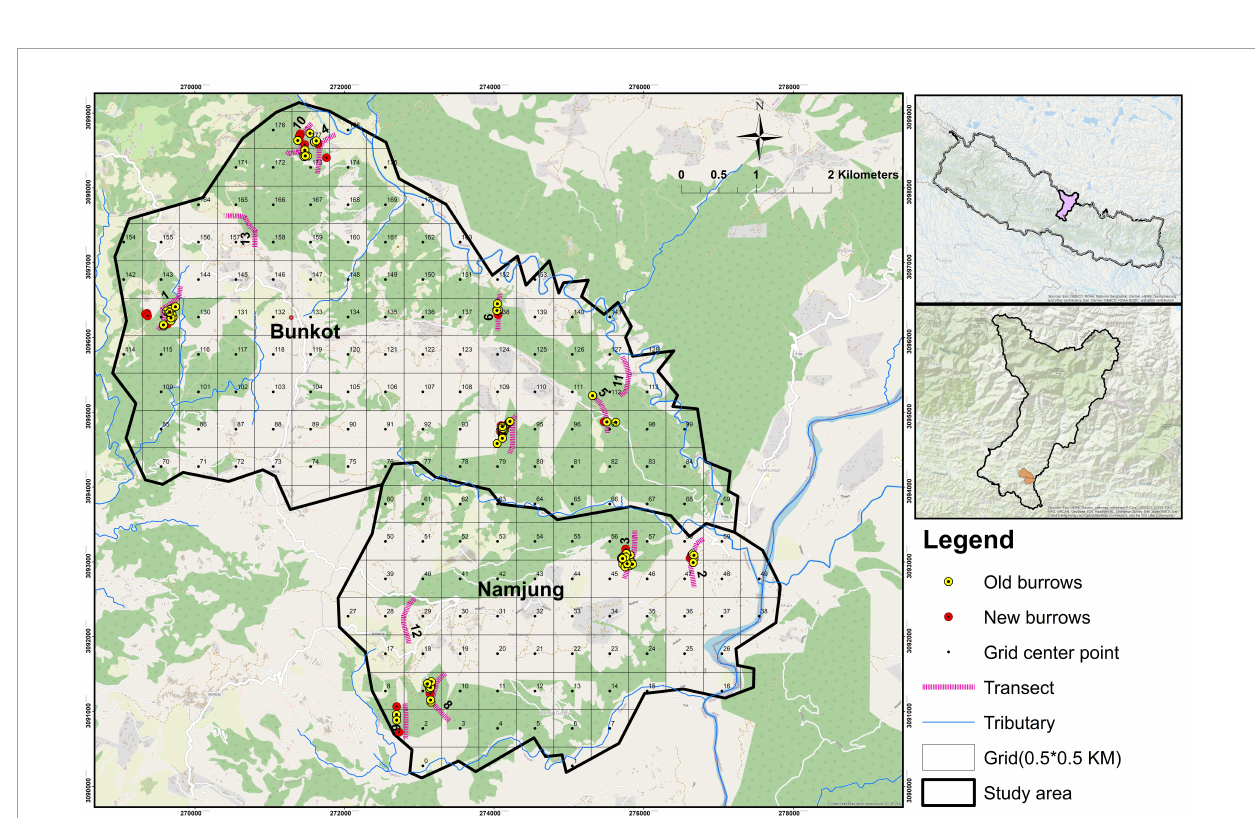
FIGURE2 Map of Gorkha District, showing the distributions of old and new burrows, and locations of the transects in the areas studied.